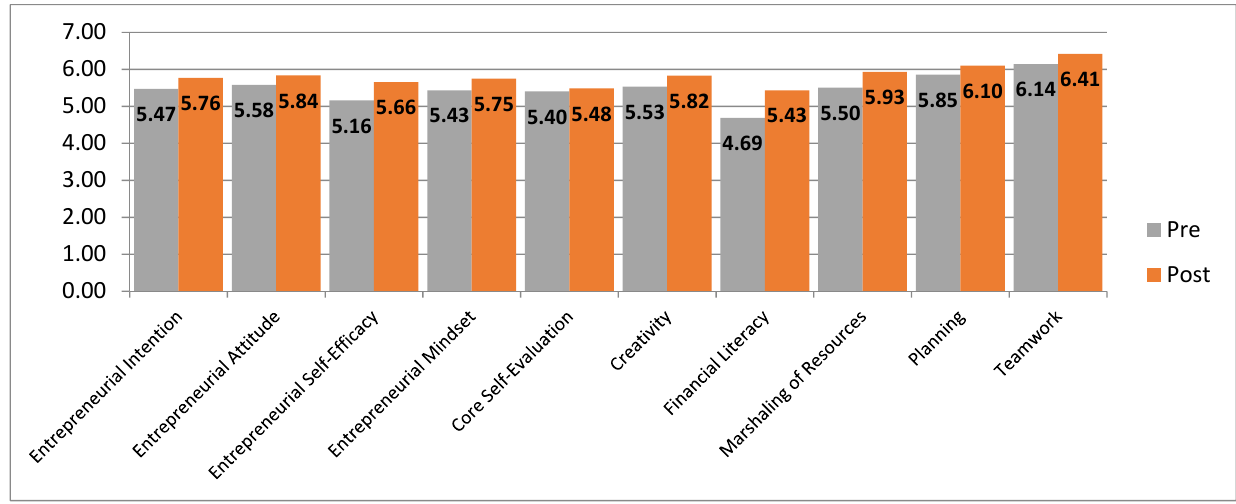
Figure 6. The average values of the entrepreneurial characteristics, pre- and post-course, of the students who had had at least one experience in practical entrepreneurship programs.